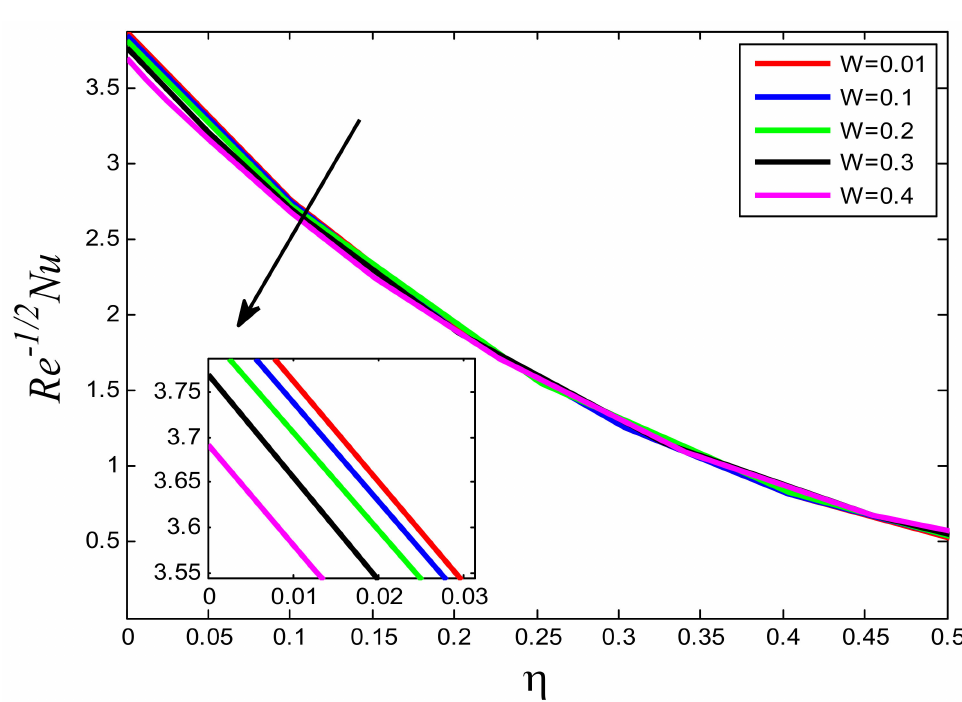
Figure 29. Influence of W on Re − 1/2 Nu